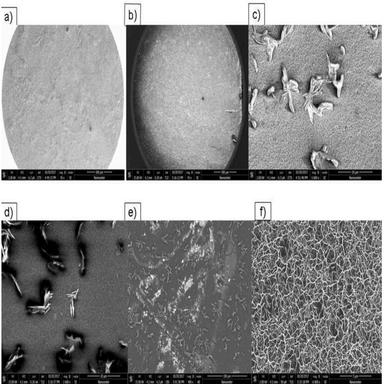
SEM micrographs of the SP paper: upper surface at low magnification a), food-facing surface at low magnification b), upper surface at higher magnification c), food-facing surface at higher magnification d), print on the upper surface e), higher magnification with some particles and rough surface f).